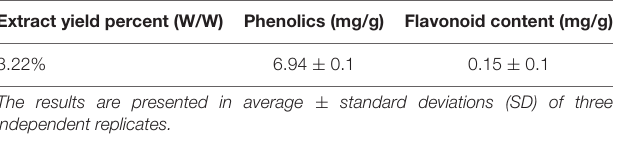
TABLE 2 | Antimicrobial screening of Pleurotus ostreatus polar extract by the method of agar- well diffusion. Microbial cultures